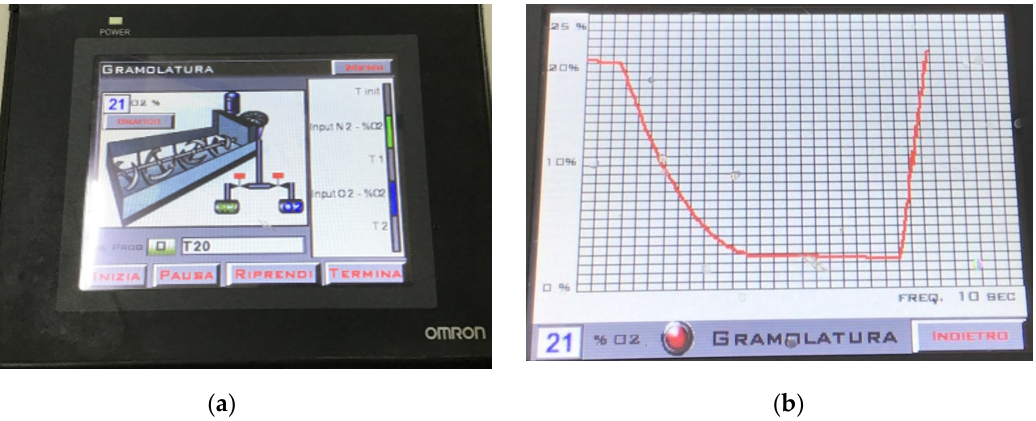
Figure 4. SCADA platform HMI (human–machine interface). ( a ) The HMI allows one to real-time manage the malaxing process with the automatic injection of O 2 and N 2 gases into the headspace of the malaxer by means of the solenoid valves present in the circuit. ( b ) The O 2 curve in the headspace of the malaxer is monitored and controlled by the operator.